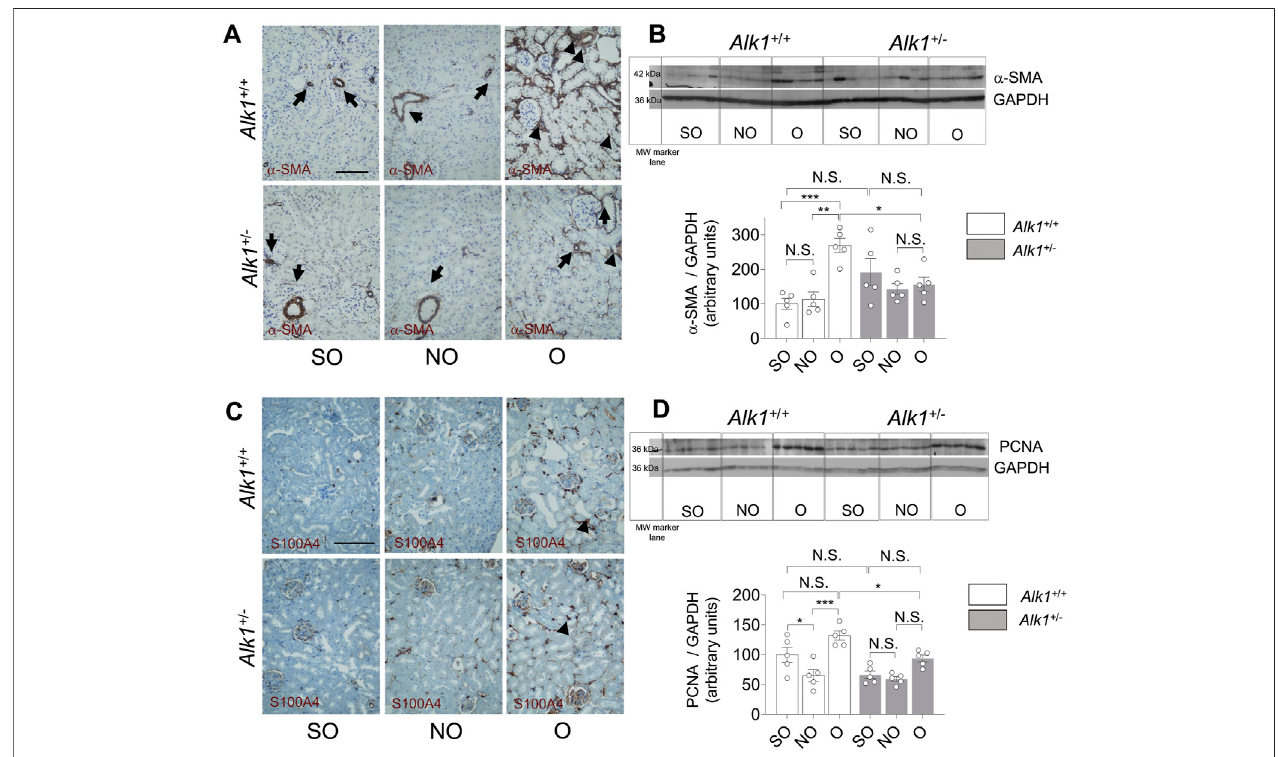
FIGURE4| Reduced myo fi broblastabundance and proliferation inobstructedkidneysfrom Alk1 +/ − mice after 3 days UUO. (A) α -SMAimmunostaining inSO, NO and O kidneys from Alk1 +/+ and Alk1 +/ − mice. (B) Western blot analysis of α -SMA protein expression in SO, NO and O kidneys from Alk1 +/+ and Alk1 +/ − mice and quanti fi cation of the corresponding densitometry analysis ( N = 5). Bars represent the ratio between α -SMA and GAPDH, used as loading control. (C) FSP1/S100A4 immunostaining in SO, NO and O kidneys from Alk1 +/+ and Alk1 +/ − mice. (D) Western blot analysis of PCNA protein expression in SO, NO and O kidneys from Alk1 +/+ and Alk1 +/ − mice and quanti fi cation of the corresponding densitometry analysis. Bars represent the ratio between PCNA and GAPDH, used as loading control. * p < 0.05; ** p < 0.01; *** p < 0.001; N.S = Not statistically signi fi cant (Two-way ANOVA). The loading control for PCNA is the same as that used in Figure 3 , as both Collagen I and PCNA were incubated in the same membrane. Arrows in (A) identify VSMCs. Arrowheads in (A) and (B) identify tubulo-interstitial myo fi broblasts. Scale bar = 100 microns in A, 150 microns in (C) .